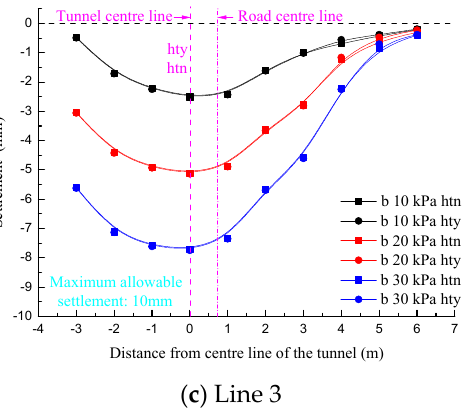
Figure 12. Longitudinal surface settlement of model B-B with D/W = 0.251.